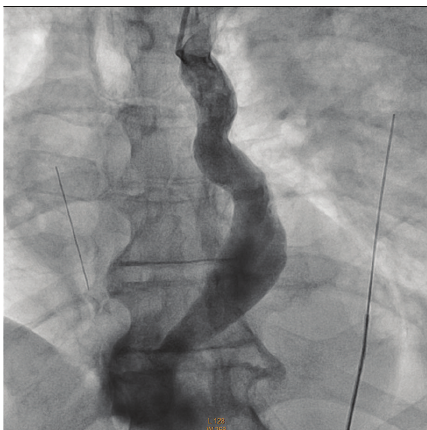
Figure 1: Venous angiogram showing contrast coursing through the persistent left superior vena cava and merging with the coronary sinus before emptying into the right atrium.